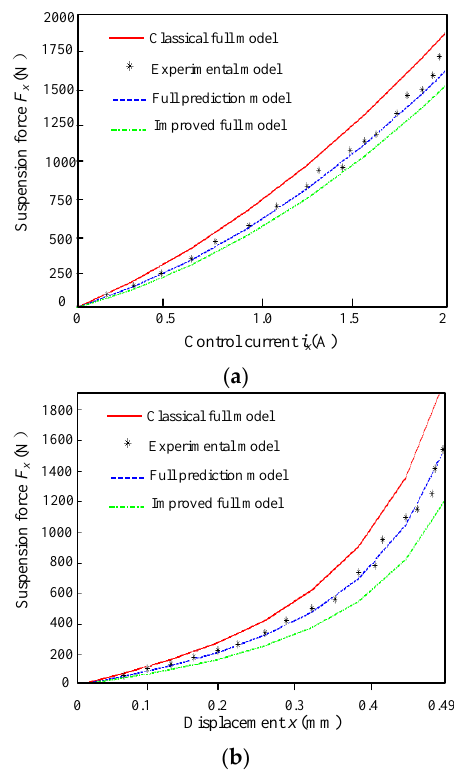
Figure 12. Comparison between the measurement result and three calculation results. ( a ) Relationship between the control current i x and radial suspension force F x ; ( b ) Relationship between the displacement x and suspension force F x .